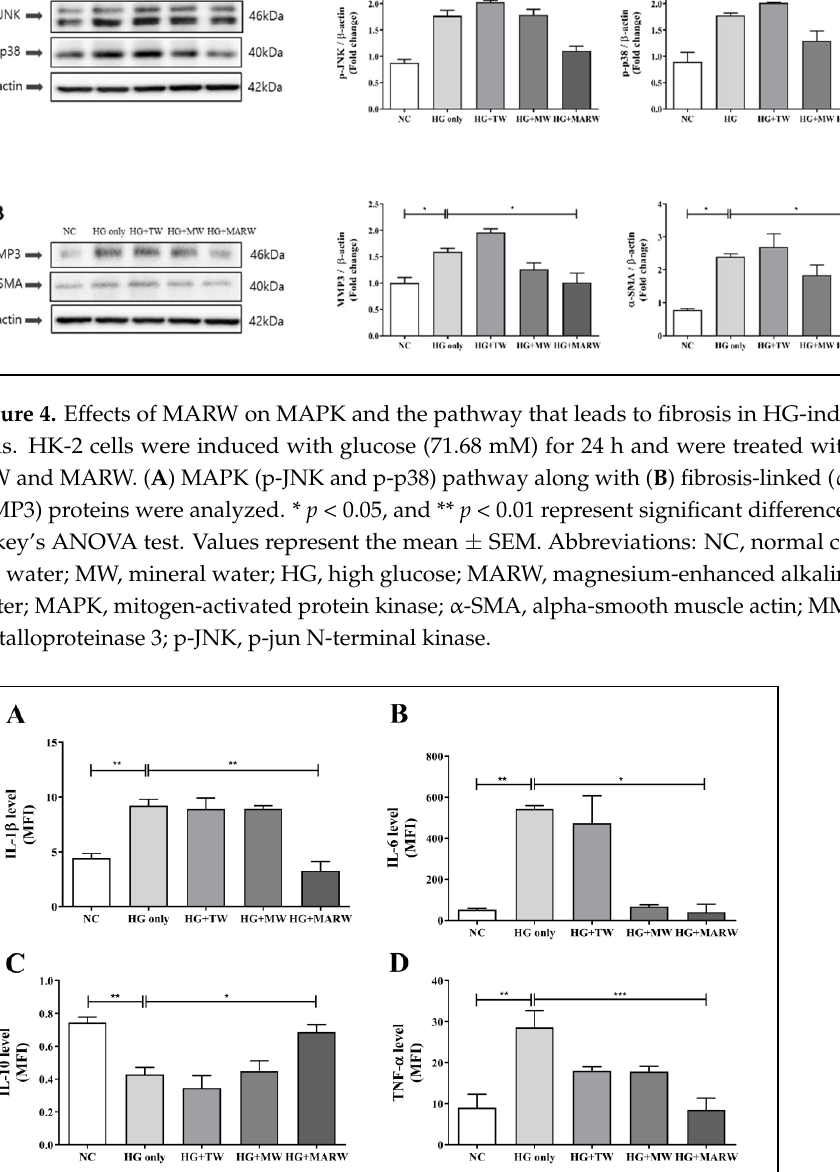
Figure 5. Effects of MARW on various cytokines associated with fibrosis-related inflammation in HG- induced HK-2 cells. HK-2 cells were induced with glucose (71.68 mM) for 24 h and were then treated with experimental waters and cytokines, including ( A ) IL-1 β , ( B ) IL-6, ( C ) IL-10 and ( D ) TNF- α , were analyzed. * p < 0.05, ** p < 0.01, and *** p < 0.001 represent significant differences based on Tukey’s ANOVA test. Values represent the mean ± SEM. Abbreviations: NC, normal control; TW, tap water; MW, mineral water; HG, high glucose; MARW, magnesium-enhanced alkaline-reduced water; IL, interleukin; TNF, tumor necrosis